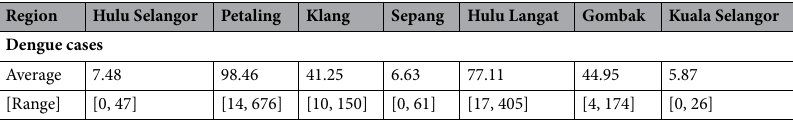
Table 2. Summary measures of dengue cases across study regions.